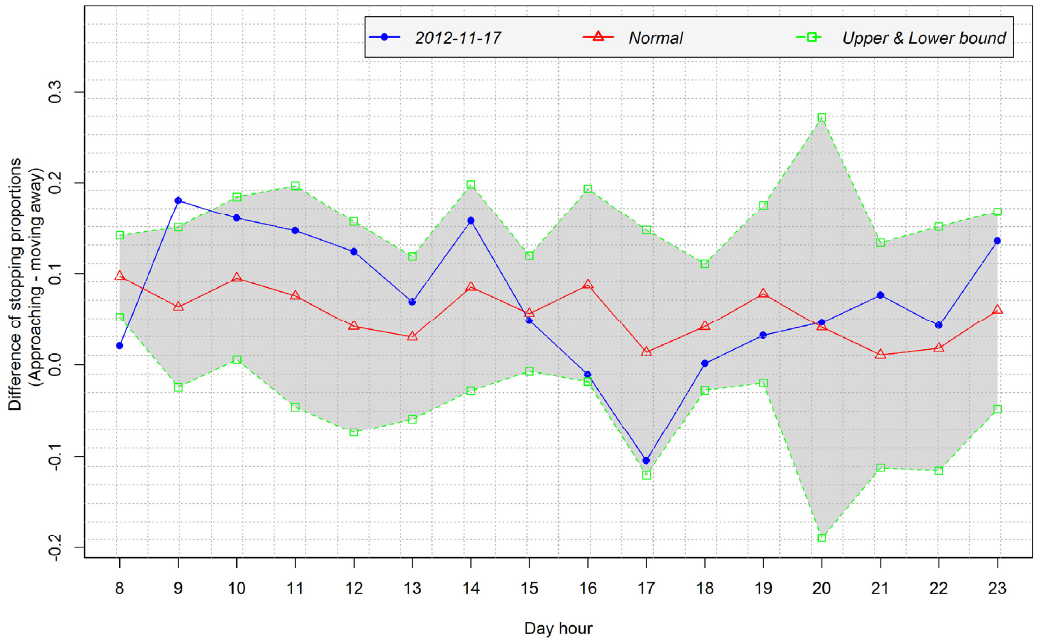
Figure 6. Temporal variation of the difference of stoppings proportions between approaching and moving-away (V) , its normal value ( W ), and its upper and lower bounds ( UV , LV ) on a day without an event.